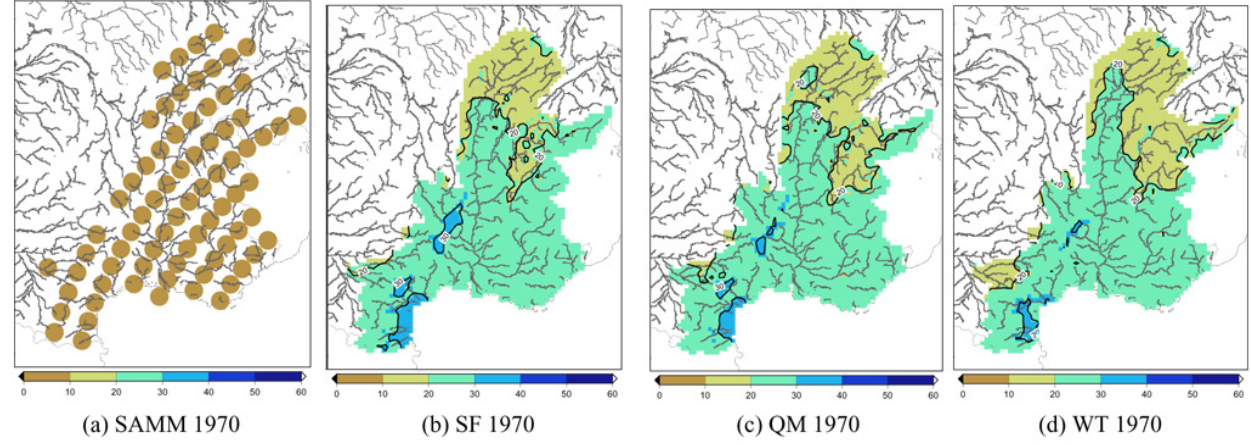
Fig. 3. PF95 in the region of interest obtained from SAMM, SAFRAN/F and the downscaling methods for the period 1970–1999.